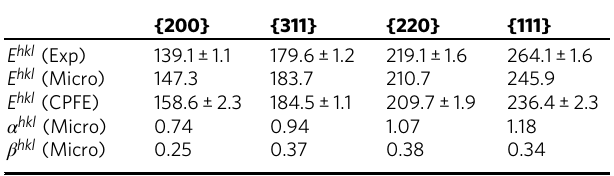
Results of E hkl are compared from the SXRD experiment (Exp), micromechanics (Micro) model and CPFEsimulation. Also listed arethe normalizedtensile stress α hkl and normalizedmaximum resolved shear stress β hkl from the micromechanics (Micro) model. See Methods for the standard deviation de fi